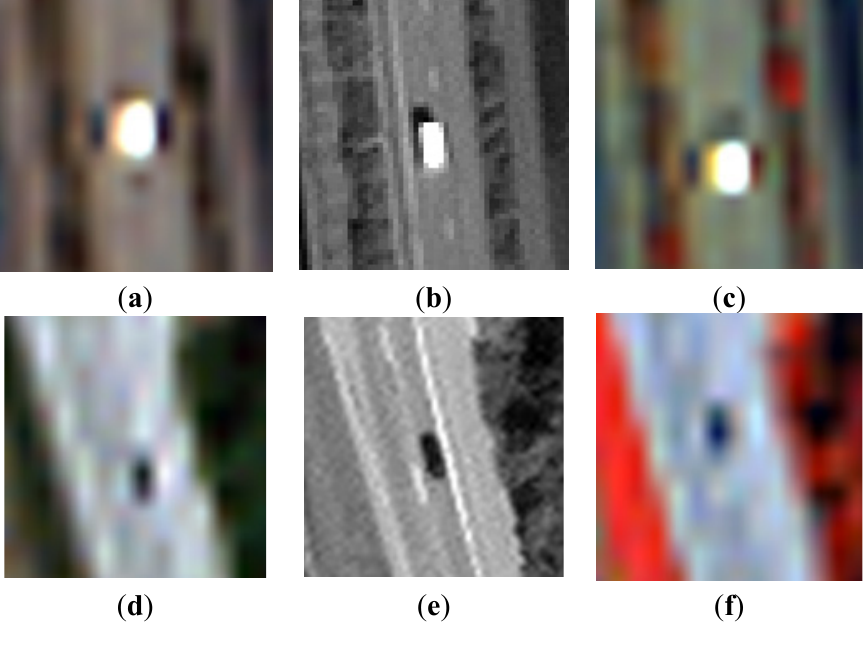
Figure 10. Regional enlarged image of moving vehicles: bright vehicle in the